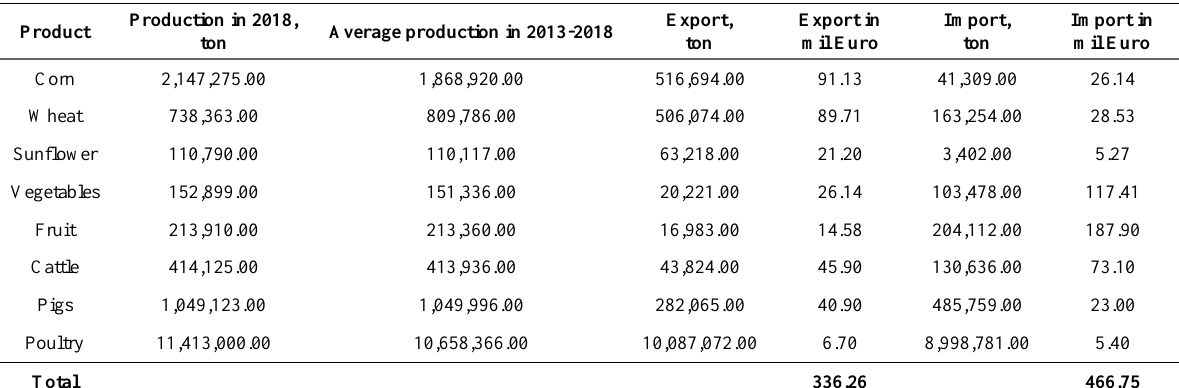
Table 1. Comparative view of agricultural production, import and export (MP, 2019)